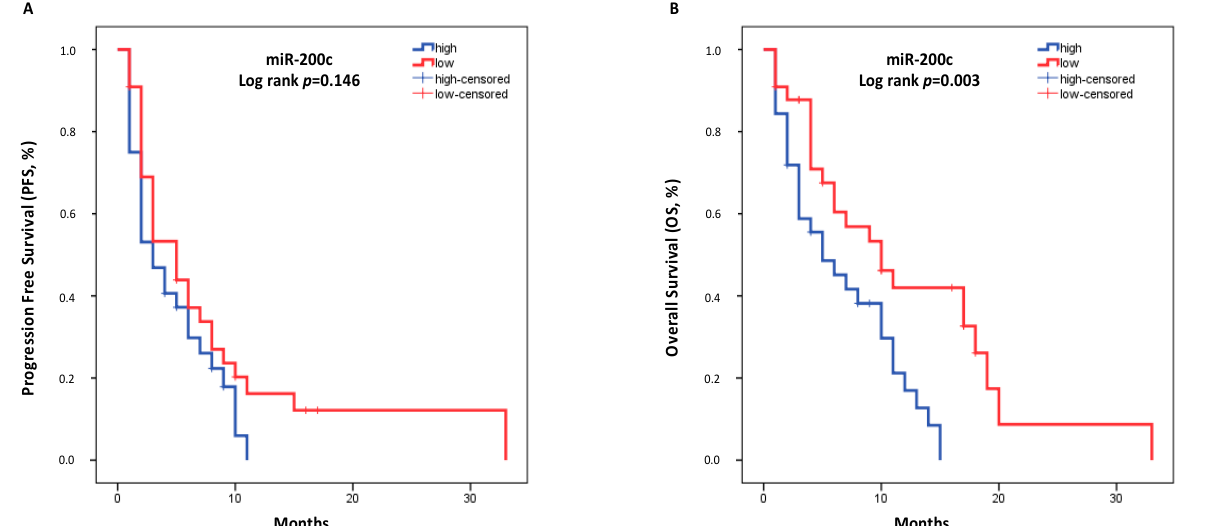
Figure 2. Kaplan–Meier analysis for PFS ( A ) and OS ( B ) based on the miR-200c expression levels in the plasma of patients with advanced NSCLC (N = 69). Median expression values classified patients into high and low expression groups. Curves were compared using the log-rank test. p -values are shown.